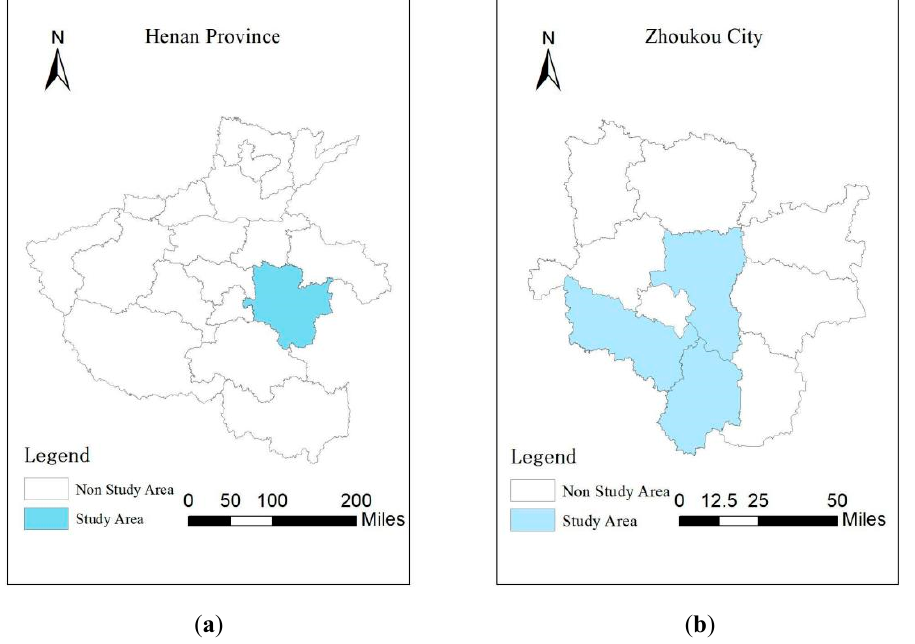
Figure 2. Location of the study areas.